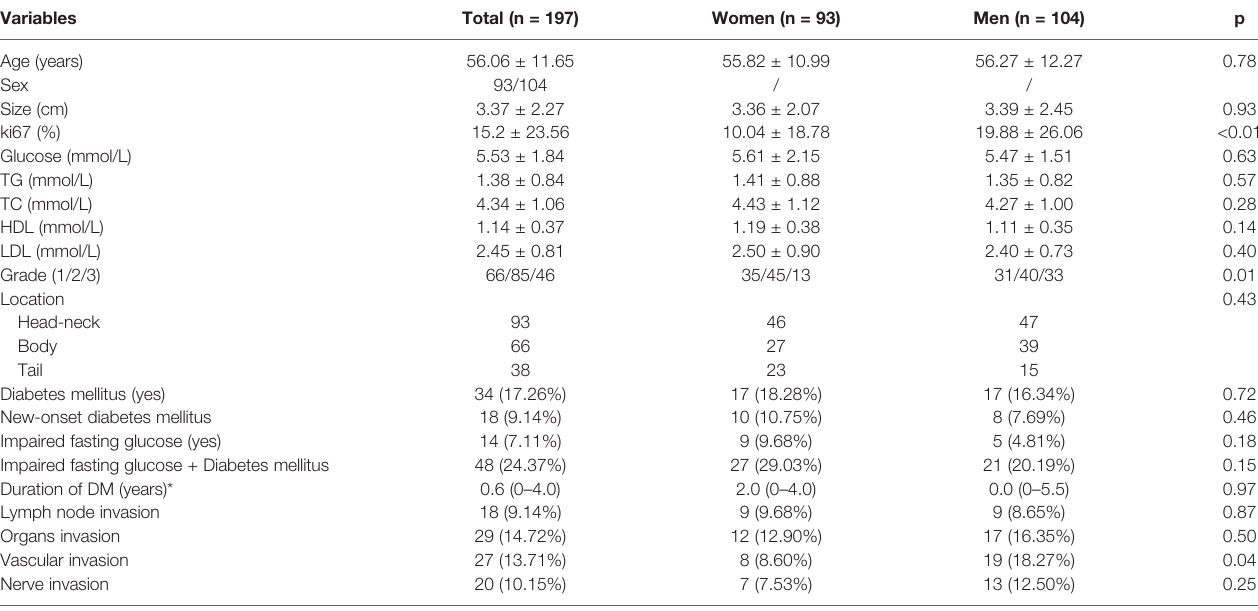
TABLE 1 | Characteristic of patients.